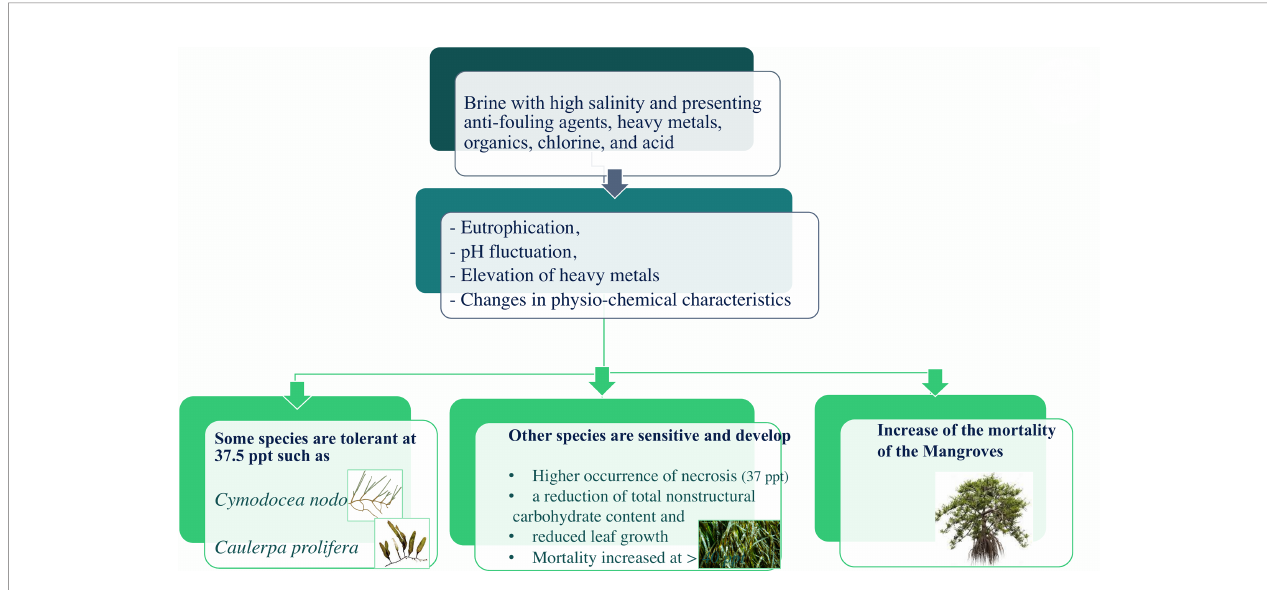
FIGURE 3 | Potential impacts of the brine ’ s salinity on fl